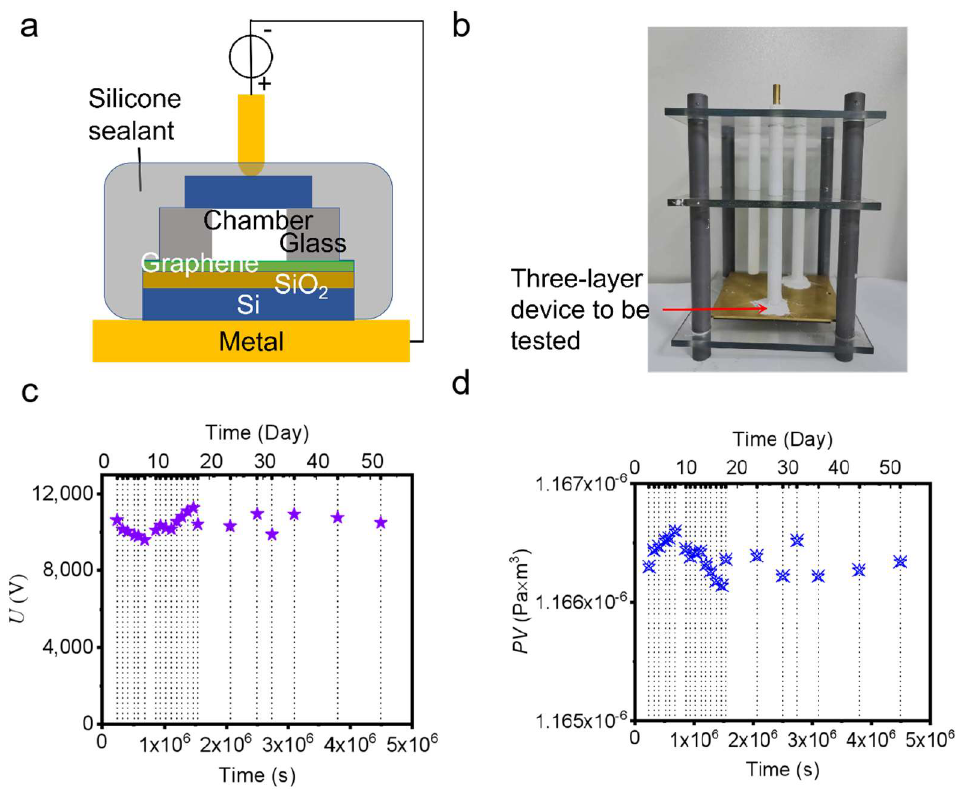
Figure 4. Sealing performance of three−layer device. ( a ) Schematic of a test apparatus; ( b ) A photograph of the apparatus; ( c ) Changes of the breakdown voltage of the three−layer device with time; ( d ) Changes of the PV of the three−layer device with time.